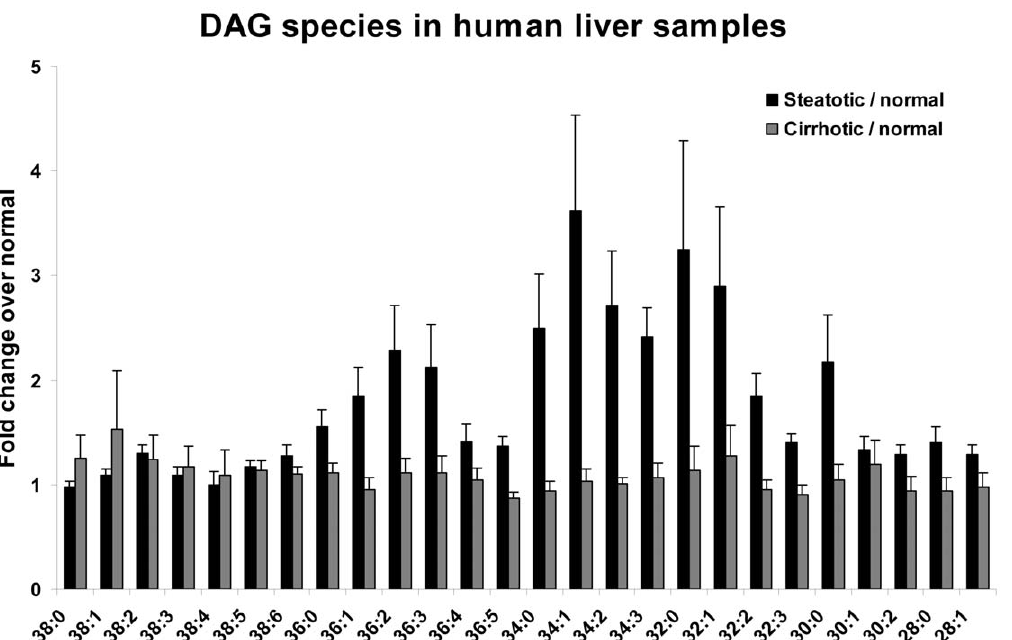
Figure 3. Fold changes in diacylglycerol (DAG) species from human livers. Fold changes in DAGs from human steatotic and cirrhotic samples versus normal samples. All fold changes for steatotic/normal samples in panel A are significant with p , 0.05 except for 38:0, 38:1, 38:3, 38:4. No fold changes for cirrhotic/normal samples in panel A are significant except 38:0,38:1,38:2 (p , 0.0122); n=5–9 individuals per group. Error bars=sem. doi:10.1371/journal.pone.0022775.g003 roles of two diacylglycerol kinase (DGK) isoforms in lipid metabolism [17], and in the study of aging and neurodegenerative diseases in a mouse model [18].